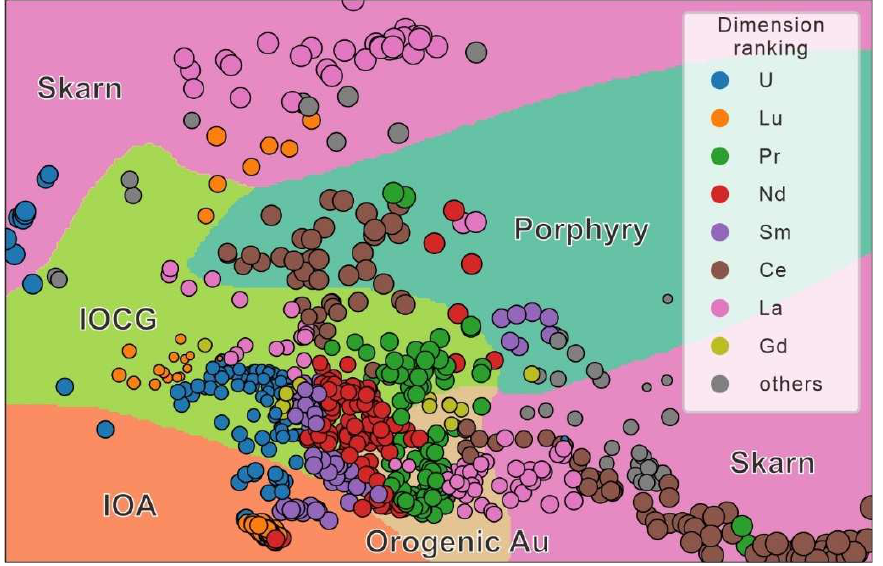
Figure 3. Attribute-based visual explanation of multidimensional projections. Elements that are top-rank for numerous points are mapped to distinct colors. Other—Eu, Dy, Yb, Sr, Y, and Th.